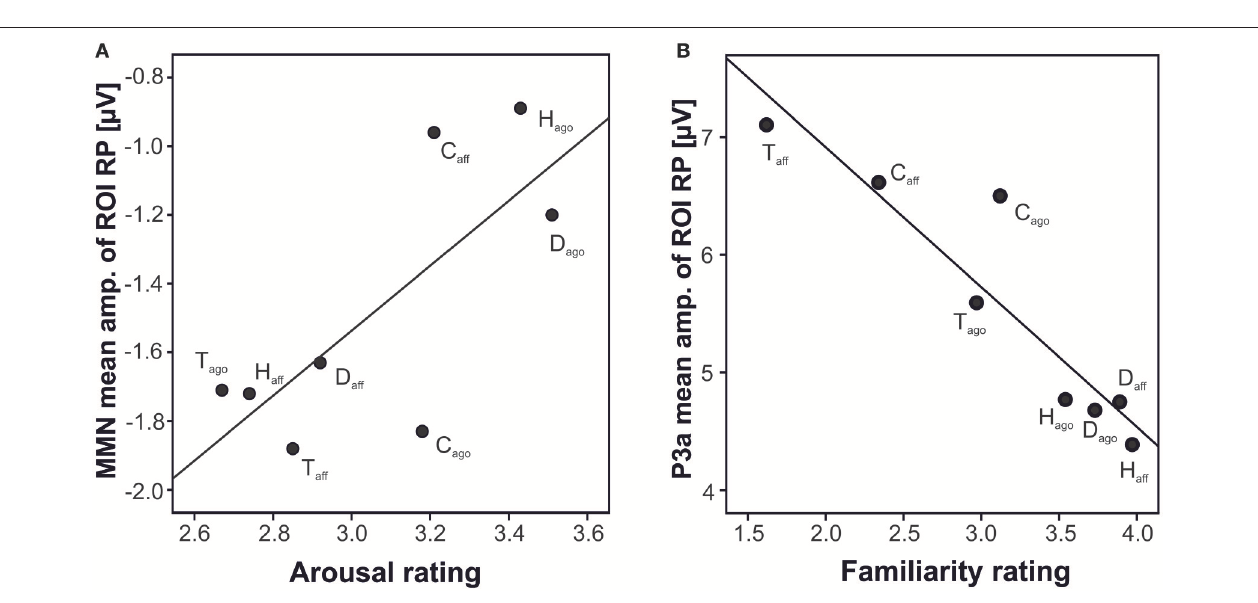
FIGURE 3 | Scatterplot of grand average amplitude of ERP components and behavioral rating per playback category at the right posterior ROIs; (A) MMN, arousal; (B) P3a, familiarity; H, human infant; D, dog; C, chimpanzee; T, tree shrew; ago, vocalizations recorded in an agonistic context; aff, vocalizations recorded in an affiliative